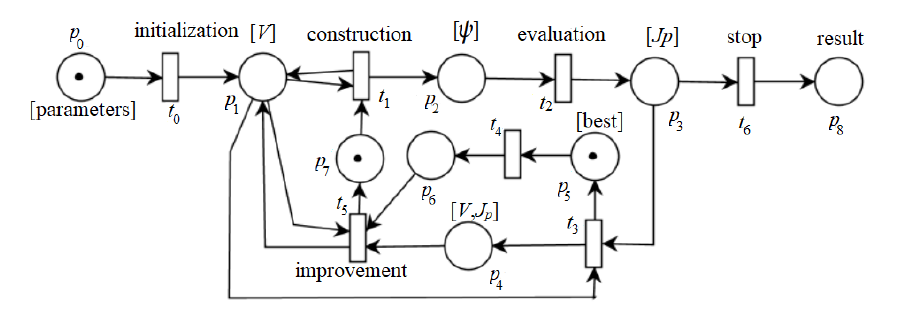
Figure 16. OETPN model of an evolutionary